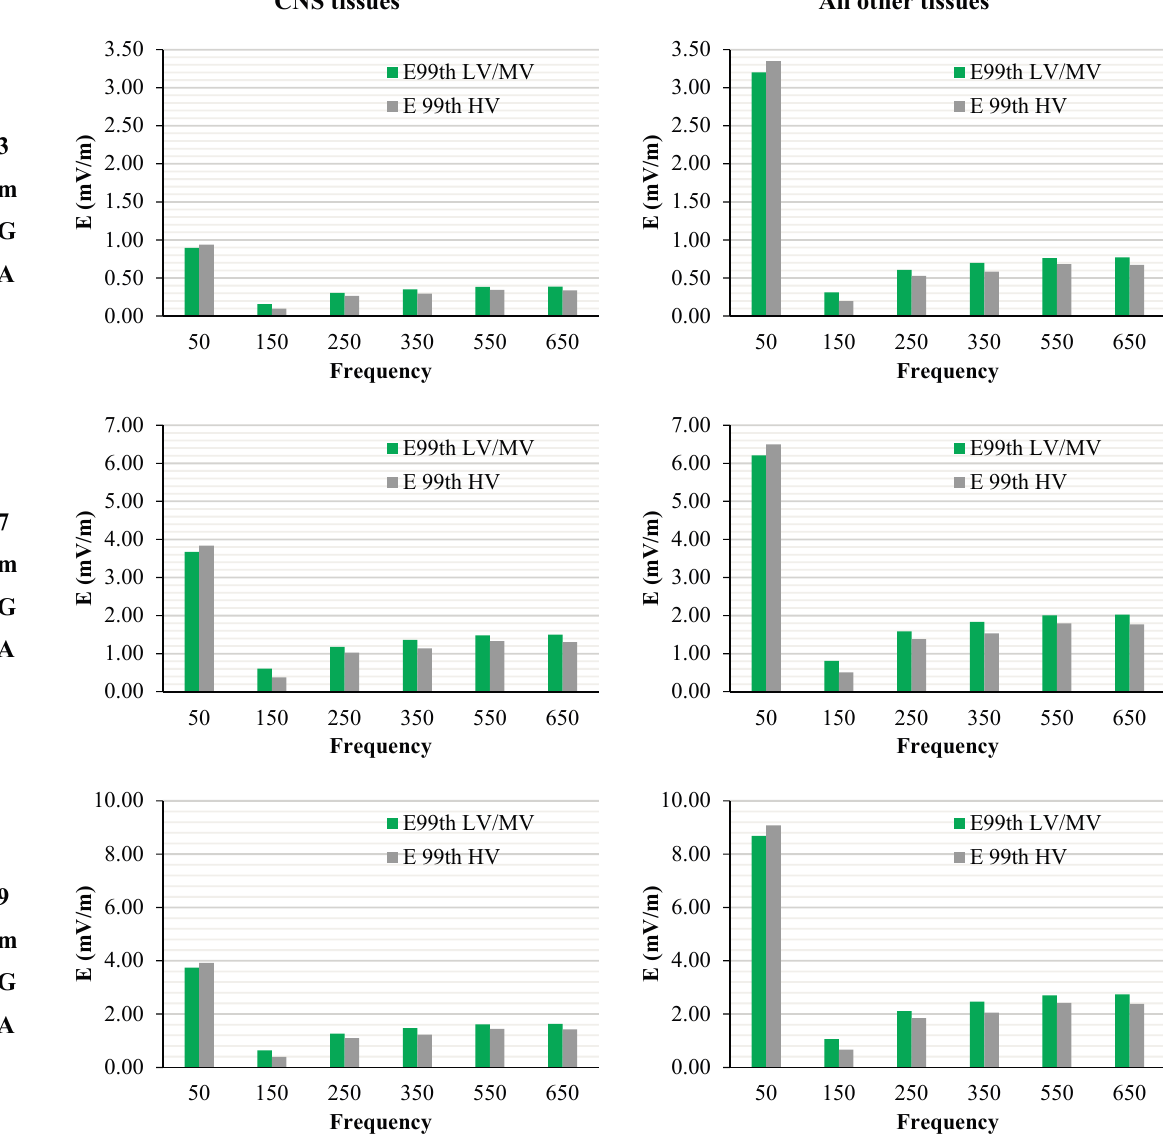
Figure 8. E 99th (mV/m) induced over CNS tissues (left) and all other tissues (right) at different GA as a function of the frequency of the component under investigation for the worst-case exposure (see the text for details). The green and grey bars indicate the two classes of networks identified by the EN 50160 standard, i.e. , Low and Medium Voltage (LV & MV) and the High Voltage (HV) networks,